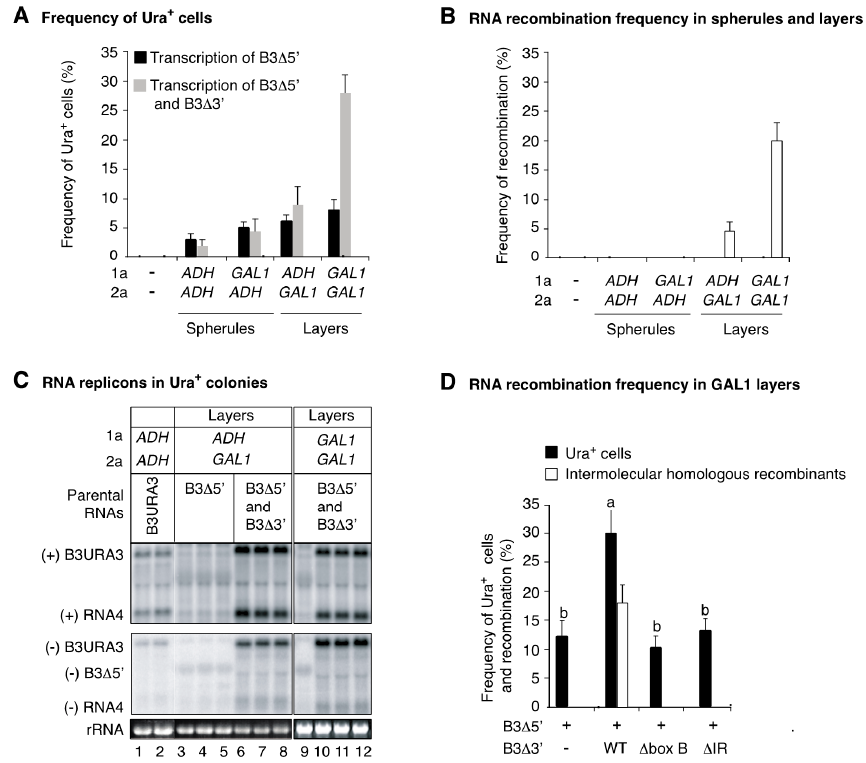
Figure 8. Intermolecular RNA recombination in layers after one yeast generation. Cells were incubated for 15 h in liquid media (8 mL) containing galactose and 500 μ M CuSO4. 1a and 2a pol were expressed from the ADH or GAL1 promoters to induce the formation of spherules or layers. Ura + cells were identified by uracil selection on plates. The average sample size was 700 cells per treatment. ( A ) Frequency of Ura + cells after transcription of B3 Δ 5 ′ alone or in combination with B3 Δ 3 ′ . Transcription of B3 Δ 5 ′ alone supported Ura + colony formation by directing RNA4 transcription. A significant ( p < 0.01) increment in the number of Ura + cells was obtained in layer-forming conditions. ( B ) Frequency of intermolecular RNA recombination in Ura + cells described in ( A ). ( C ) The presence of intermolecular RNA recombinants was confirmed by analyzing 48 Ura + colonies individually grown for 36 h in cultures (8 mL) lacking uracil and copper. RNA was extracted an analyzed by Northern blotting using URA3 probes. Representative blots are shown. B3URA3 was a size marker (lanes 1 and 2). (+) and ( − ) indicate RNA of positive or negative polarity, respectively. As illustrated in Figure 7A, B3 Δ 5 ′ supported negative-strand B3 Δ 5 ′ synthesis and RNA4 transcription (lanes 3, 4, 5 and 9). Lanes 6, 7, 8, 10, 11 and 12 are intermolecular RNA recombinants. ( D ) Frequency of Ura + cells obtained after transient transcription of B3 Δ 5 ′ and wild type or mutant (box B or intergenic region deletion) B3 Δ 3 ′ for one yeast generation in GAL1 layers. Induction of transcription, selection, and identification on intermolecular RNA recombinants was as in ( A , B ). Bars represent the average and standard error of three biological replicates. Bars with the same letter are not significantly different (Tukey ʹ s test with alpha = 0.01).